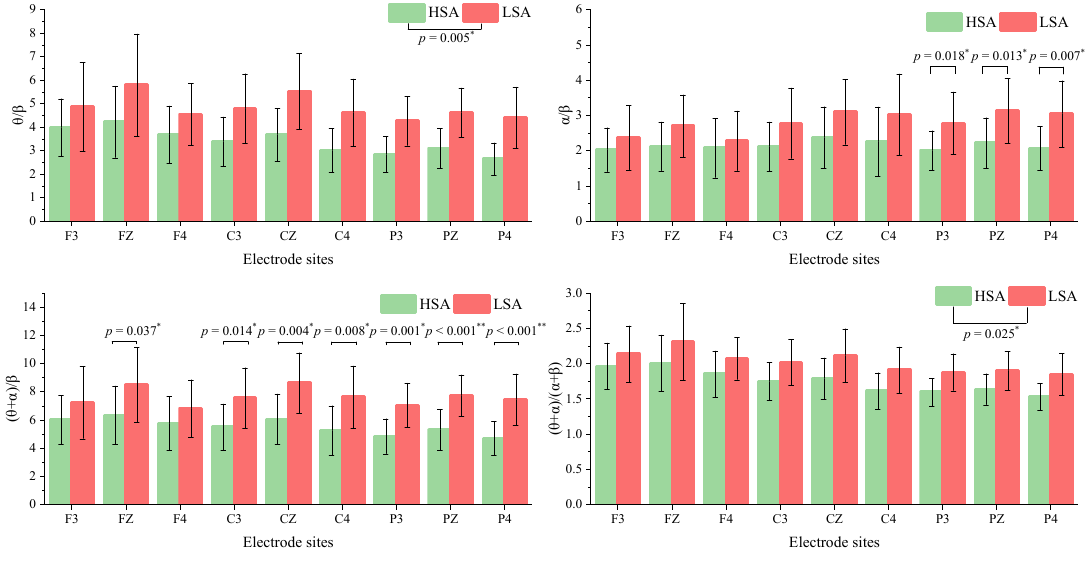
Figure 5. Four SW/FW ratios for the two SA groups. Table 3. ANOVA results of SW/FW ratios for the two SA groups.